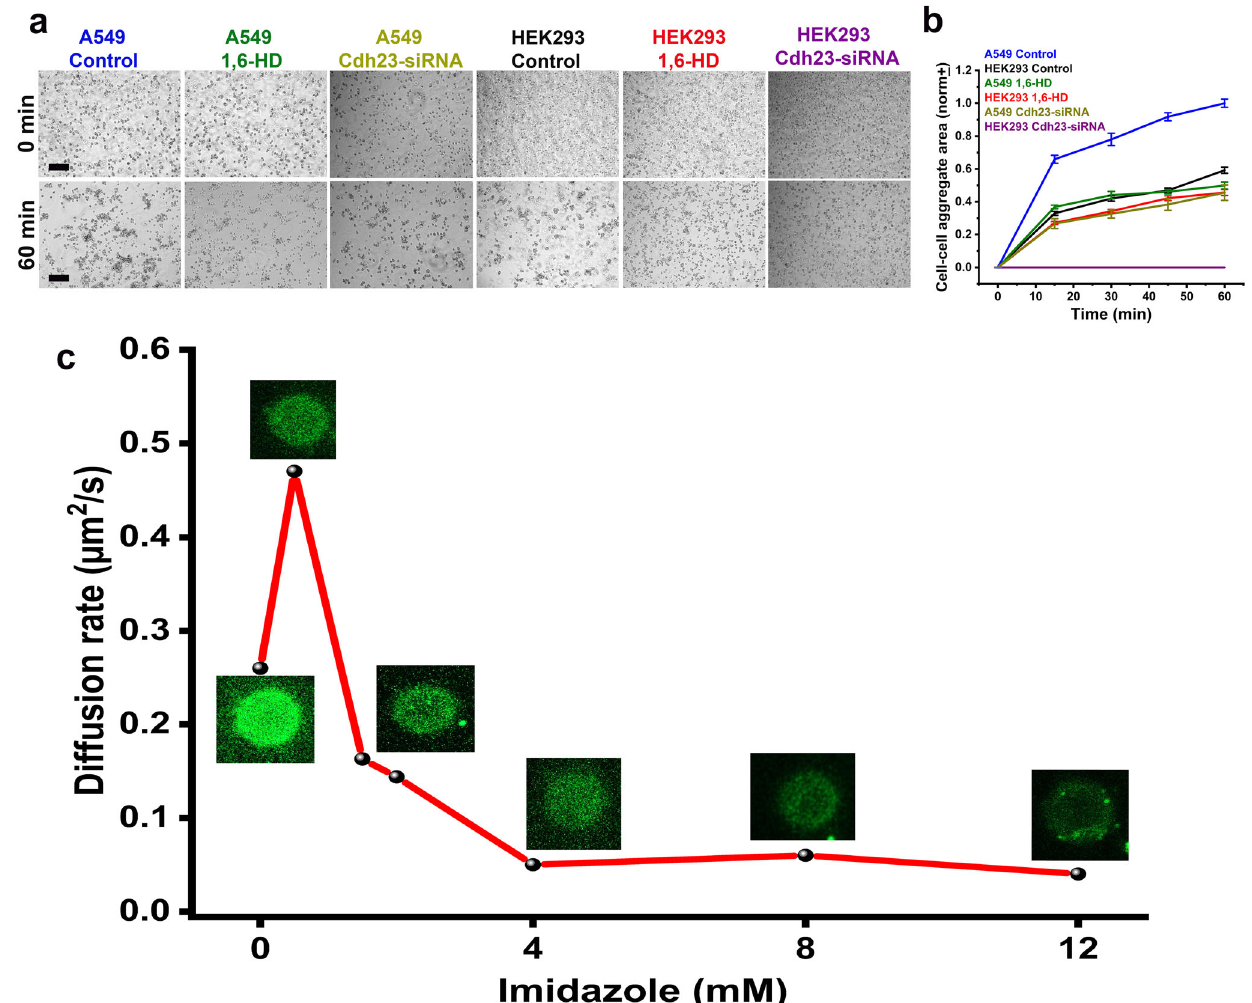
Fig. 4 Effect of disrupted cis-clusters on cell-adhesion kinetics. a Time-stamp bright- fi eld images of cell aggregates of A549 and HEK293 cells in the absence (control) and presence of 1,6-HD, and treated with Cdh23-siRNA. Scale bar: 50 µ m. b Growth of cell-cell aggregation area (in µ m 2 ) with time for A549 cells in control (blue), treated with 1,6-HD (olive) and Cdh23-siRNA (dark yellow), and HEK2923 cells in control (black), treated with 1,6-HD (red) and Cdh23-siRNA (purple). Error bars represent the standard error of the mean (SEM) for N = 15 aggregates. All the individual data points are shown in the scattered plots in the supplementary fi le. c The gradual change in the diffusion-rates ( μ m 2 /s) of Cdh23 EC1-27 anchored to GUV membranes by His- tag with increasing concentration of imidazole